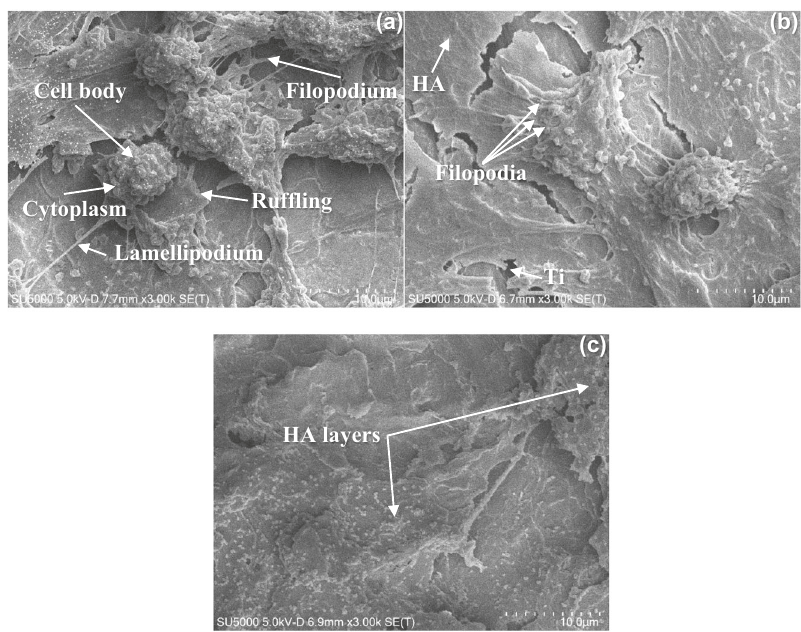
Fig. 2 Annotated SEM images taken at day 28 from one random location on a TI, b TI- HA-AD and c TI-HA-ANN